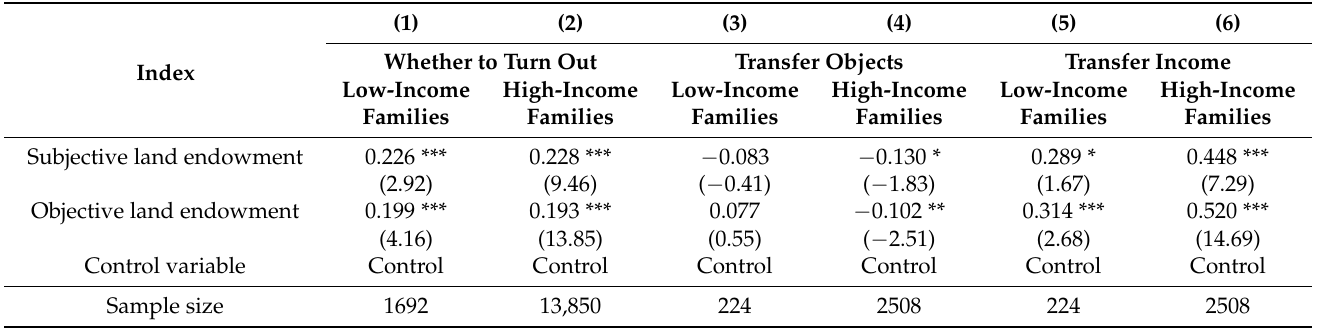
Table 4. Subsample regression